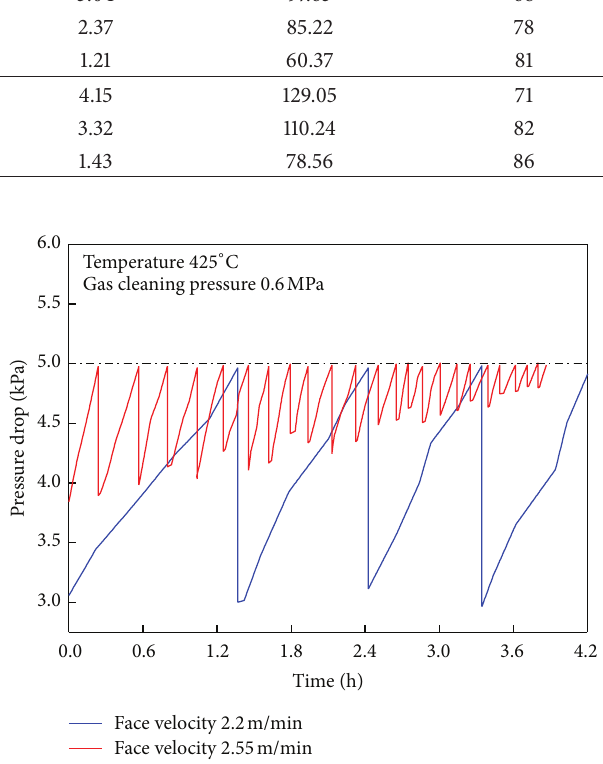
Figure 12: Pressure drop variations for face velocities of 1.15m/min and 1.5m/min. Figure 13: Pressure drop variations for face velocities of 2.2 m/min and 2.55